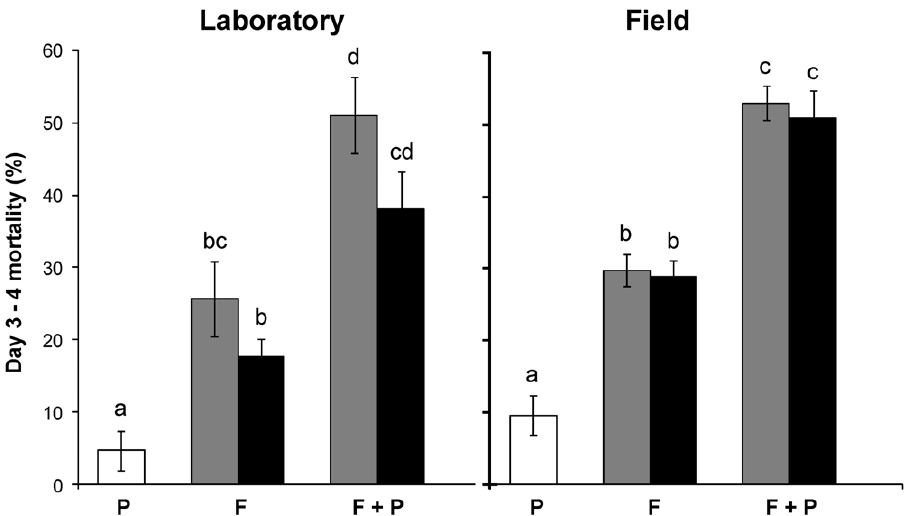
Figure 4. Effect of permethrin on fungal virulence. Mean ( 6 SEM) percentage mortality measured at day 4 of uninfected (white), Beauveria - infected (grey) and Metarhizium -infected (black) kdr mosquitoes from the laboratory colony (left) and field population (right), which were exposed to permethrin (P), fungus (F) or both (F + P) on day 0. Data represent five and four replicates of 28 laboratory and field mosquitoes, respectively. Significant group differences are indicated by non-corresponding